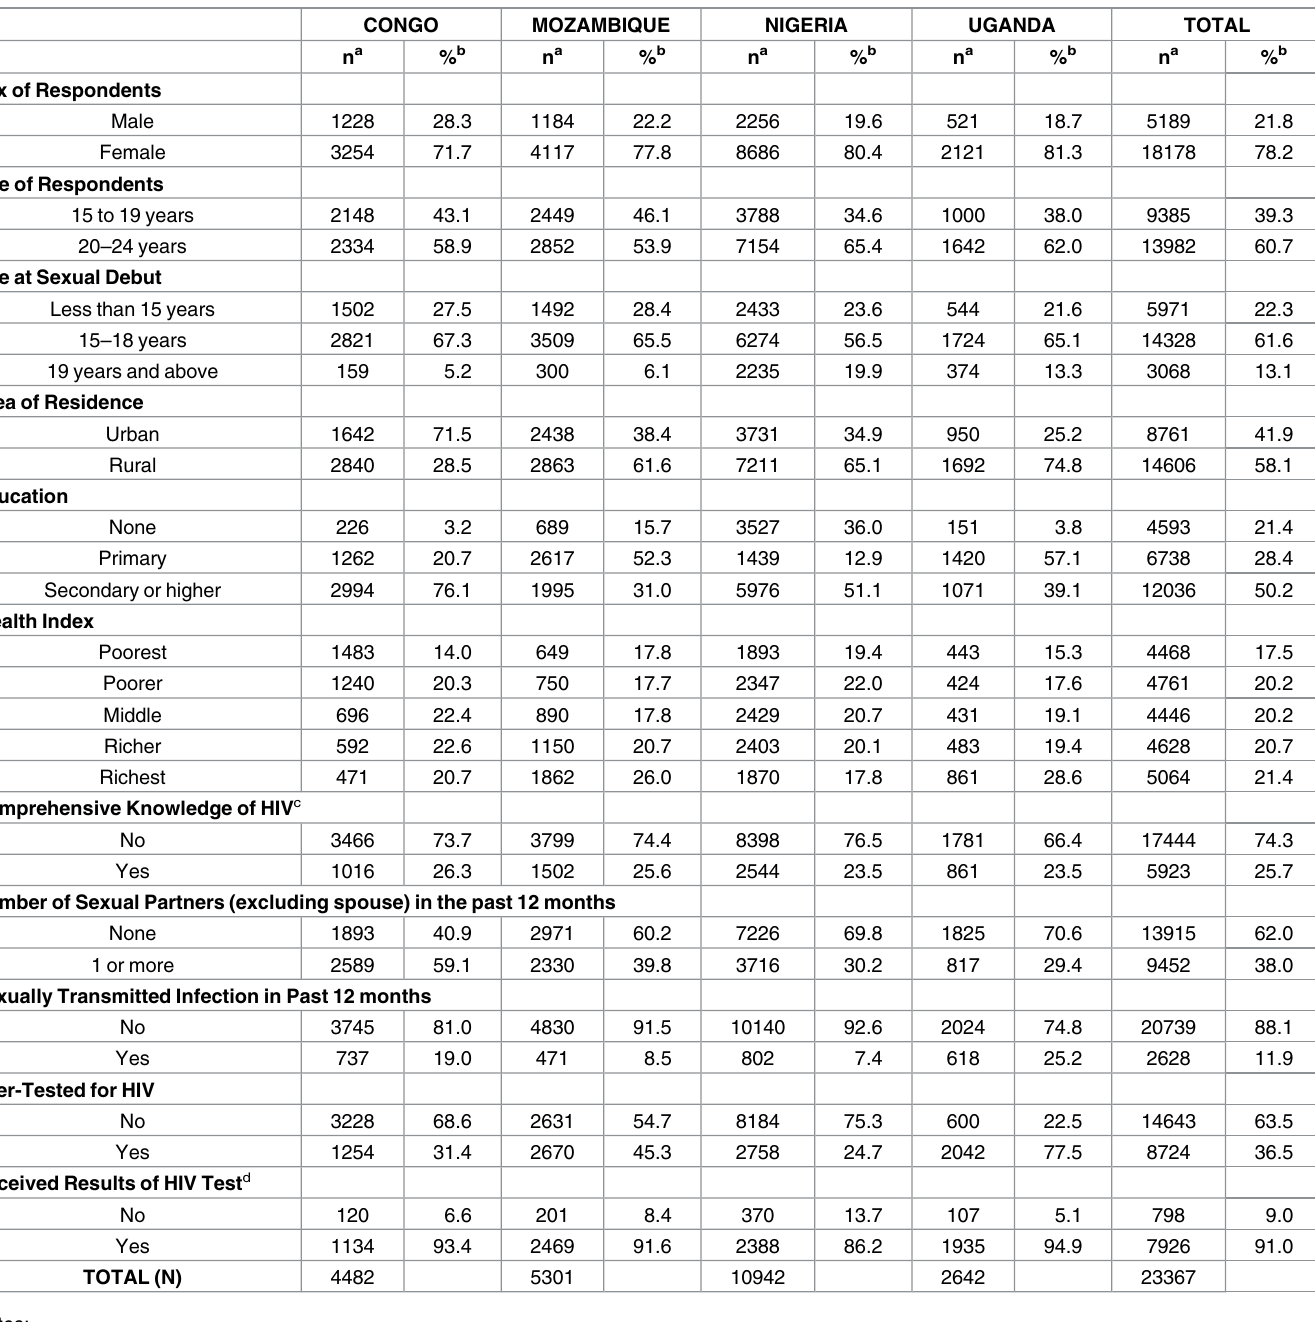
Table 1. Demographic and health characteristics of